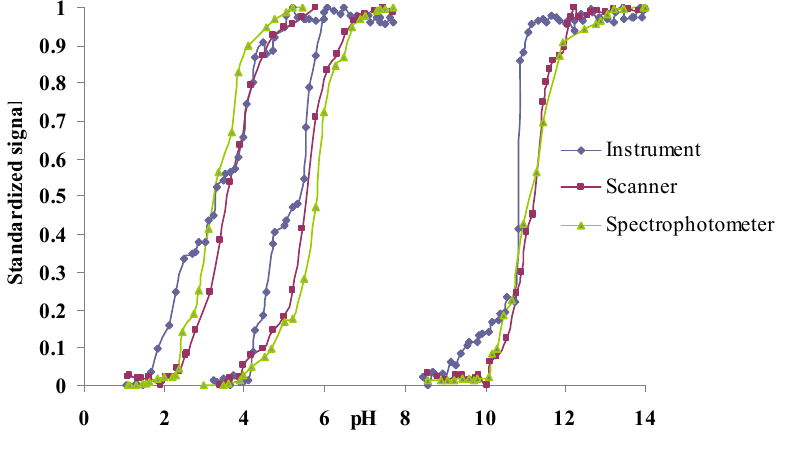
Figure 4. Comparison between the responses to pH of different sensing elements using different devices for three array